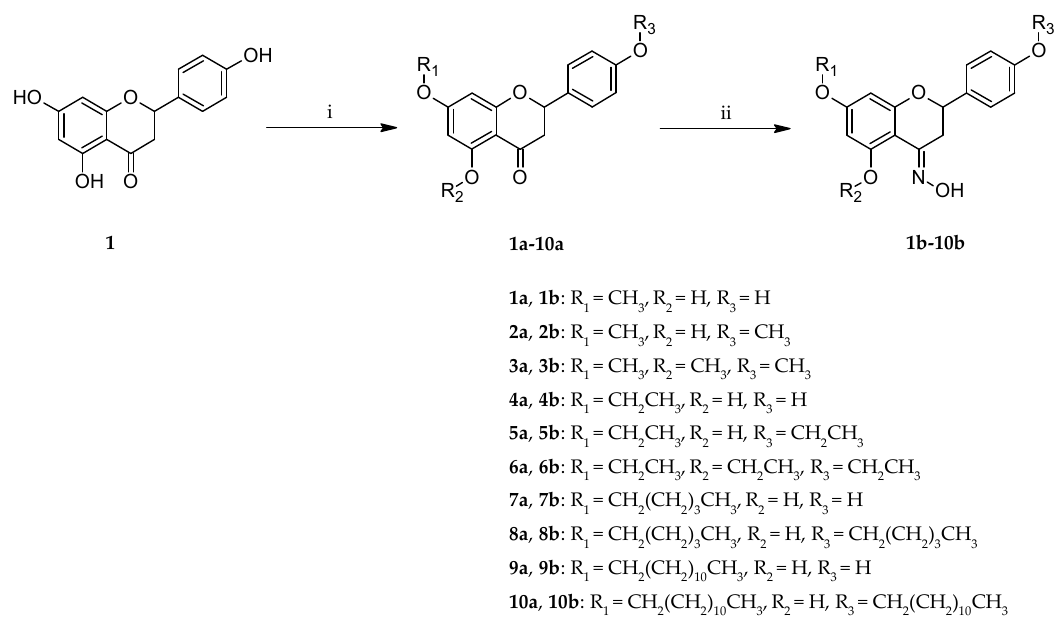
Table 1. Antimicrobial activity of O -alkyl derivatives of naringenin 1a – 10a .